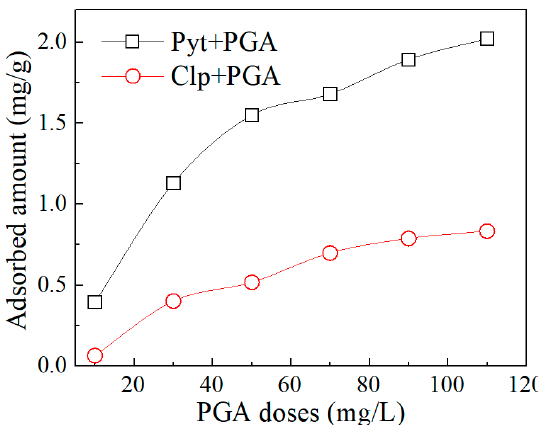
Figure 7. PGA adsorption on pyrrhotite (Pyt) and chalcopyrite (Clp) at different concentrations of PGA at pH 8.